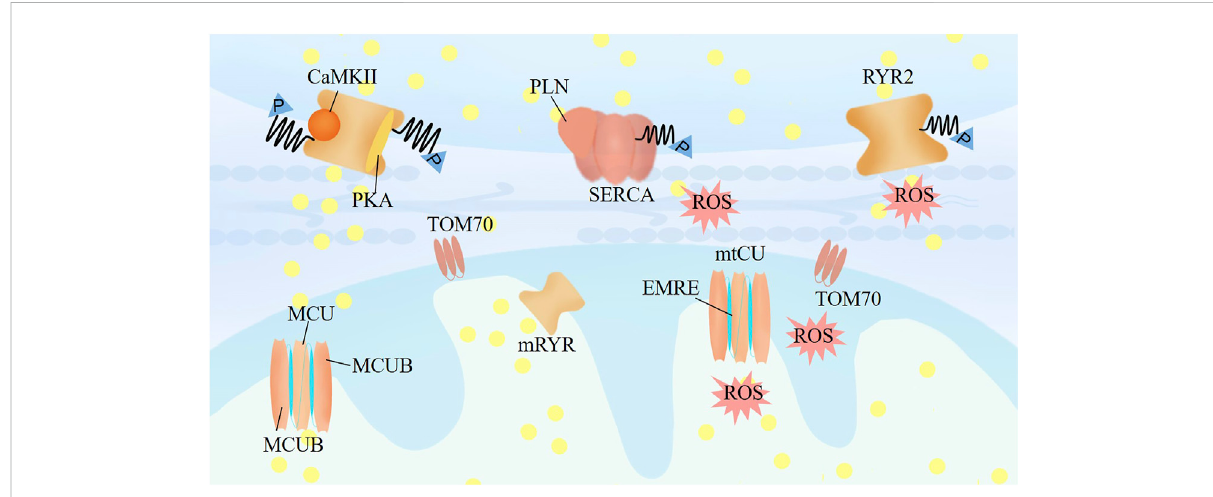
FIGURE 2 The mechanismscrosstalk between calciumand mitochondrial homeostasis. RyR2 activity isregulated by thephosphorylation level of RyR2 by theproteinkinaseA(PKA),Ca2+/calmodulin-dependentproteinkinaseII(CaMKII),andproteinphosphatasetype-1andtype-2A,associatingwiththe Ca2+ level of SR. TOM70 regulates the constitutive of Ca2+ shuttling from ER to mitochondria. Mitochondrial RyR in the IMM could be activated as soon as Ca2+ released from the ER, and further increasing of mitochondrial Ca2+ would lead inactivation of mRyR1 to prevent mitochondrial Ca2+ overloading and permeability transition pore opening. Mitochondrial uptake calcium mainly through mtCU, which is a dedicated regulator for mitochondrial responding different stress to match cardiac workload with ROS and ATP